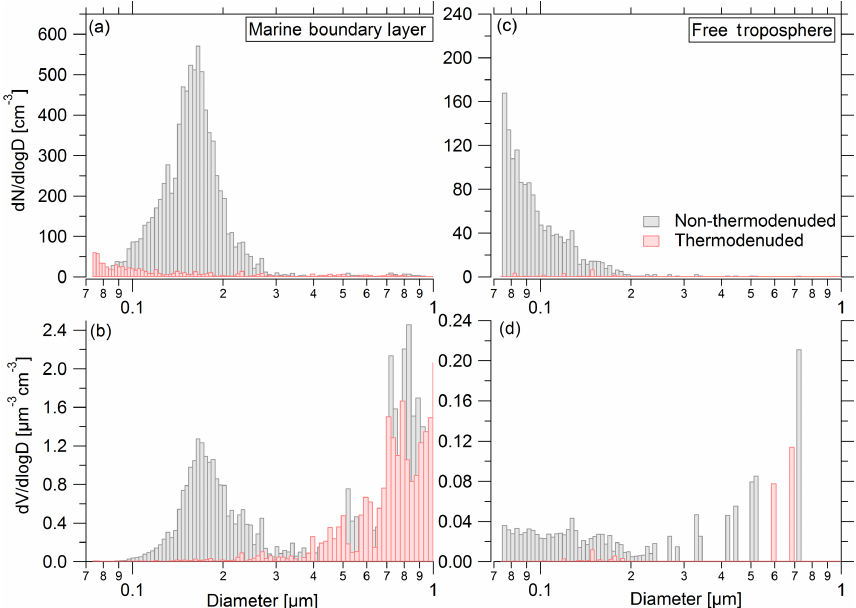
Figure 11. Example of an averaged dry aerosol size distribution from UHSAS-1-TD and UHSAS-2 as sampled in the MBL (21.74 ◦ N, 1080hPa; 27 January 2017, 01:15:26–01:16:16UTC) showing (a) number and (b) volume; and for a separate size distribution sampled in the FT (3.4 ◦ N, 293hPa; 26 January 2017, 21:32:47–21:38:47UTC) showing (c) number and (d) volume. For particles with D p between 0.1 and 0.9µm, in the MBL case (a, b) 94% of the total number and 52% of the total volume volatilized in the thermodenuder, while in the FT case (c, d) 96% of the number and 74% of the volume